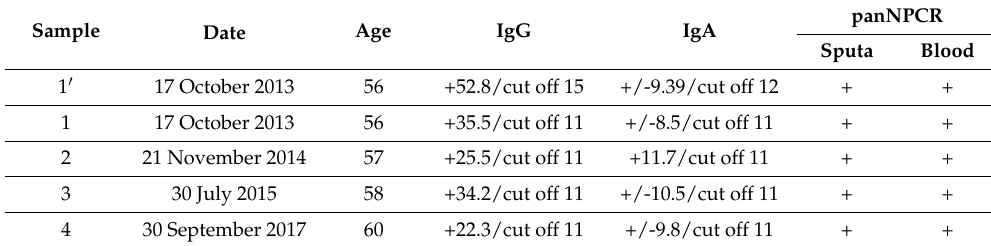
Table 6. ELISA vs. panNPCR from the sputa and blood from the same individual.